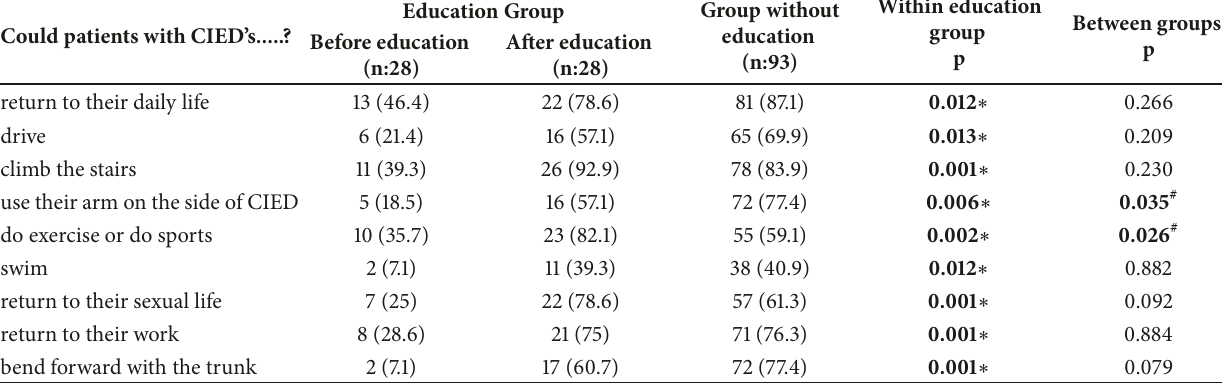
Table 3: Correct responses of patients with cardiac implantable electronic devices (CIED) for physical or daily life activities. Could patients with